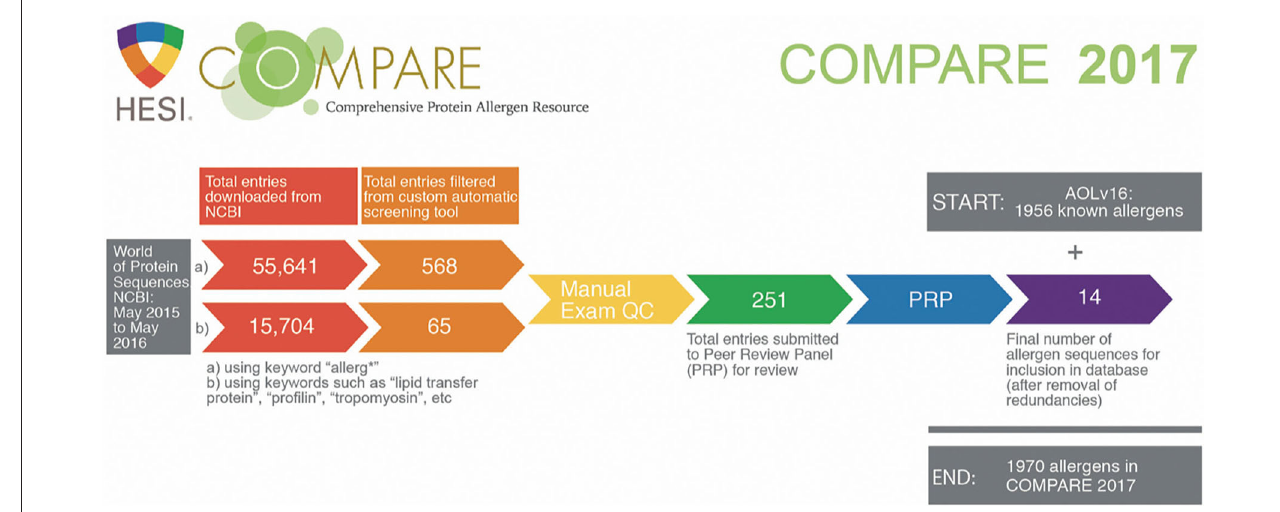
FIGURE 2 | COMPARE 2017 screening process quantitative outcomes (supporting information provided in Appendix-2 of the Supplementary Materials